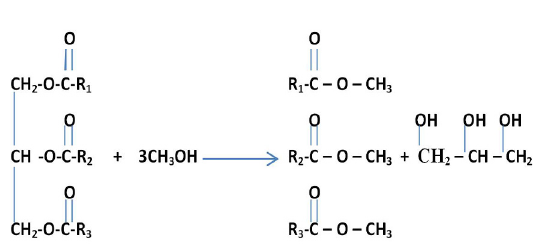
Figure 4. Trans esterification reaction to produce Biodiesel.